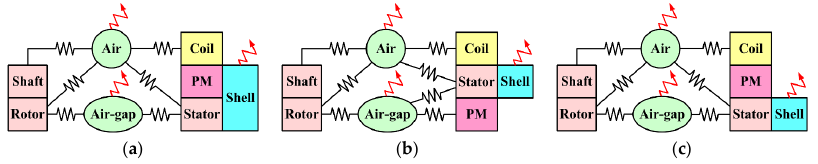
Figure 14. Configuration of the heat equivalent circuits for four HEFS machines. ( a ) PM ‐ top; ( b ) PM ‐ bottom; ( c ) PM ‐ middle ‐ 1& ‐ 2. Table 3. Thermal and mechanical properties of different materials.